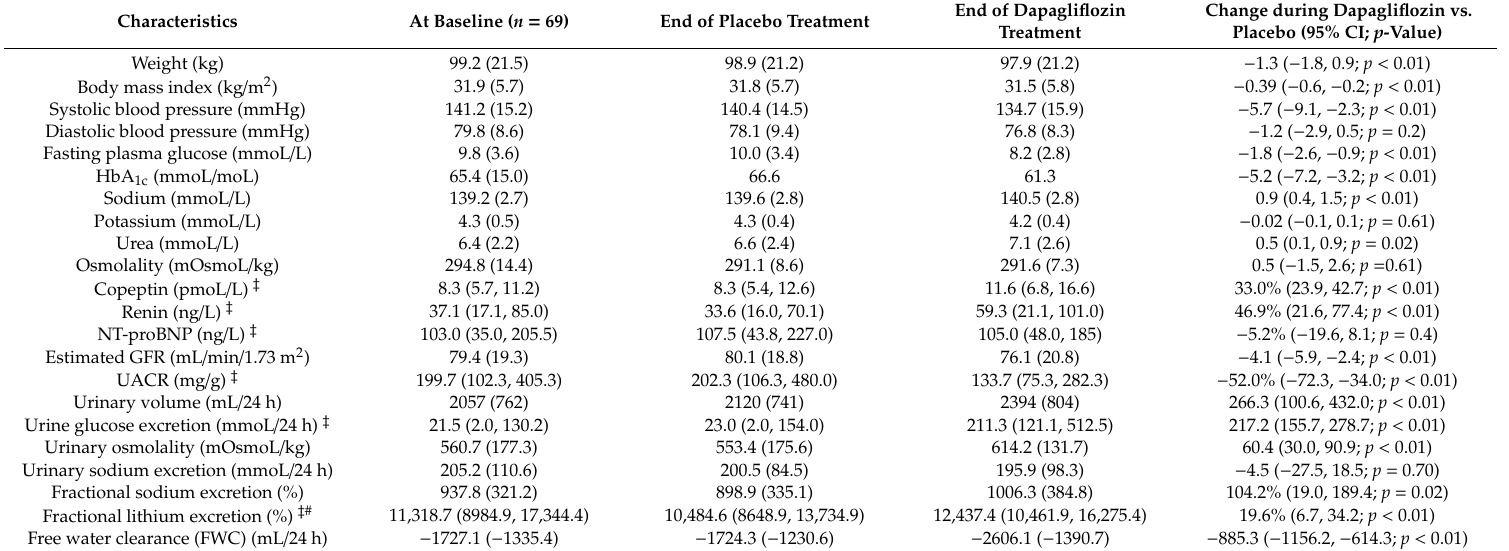
Table 1. Volume markers at baseline, at the end of placebo treatment, and at the end of dapagliflozin treatment, and changes in volume markers during dapagliflozin treatment versus placebo in the merged database (IMPROVE study and DapKid